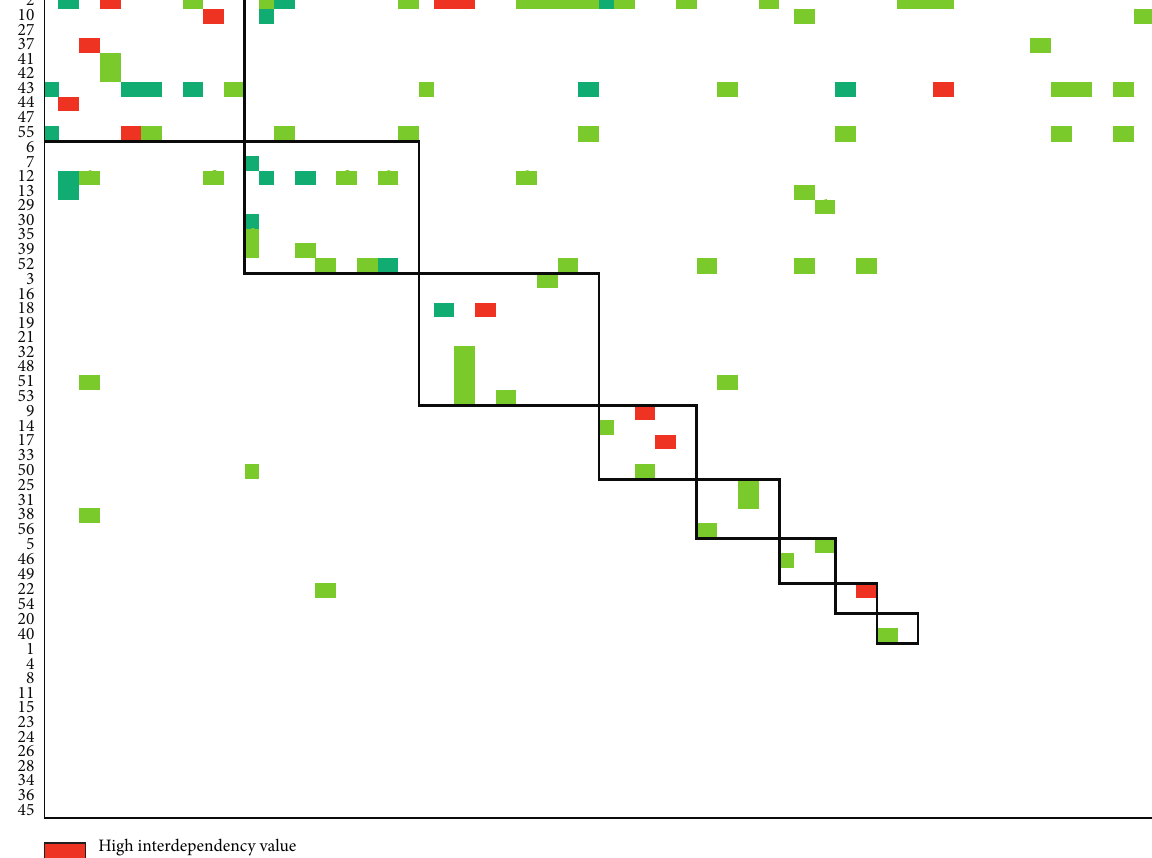
Figure 7: Illustration of the proposed clusters in the tramway project